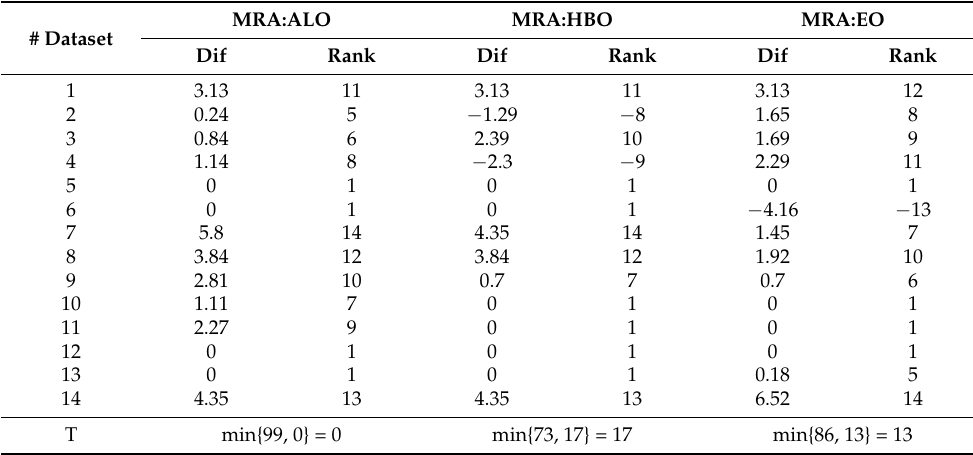
Table 4. Wilcoxon signed-rank for test